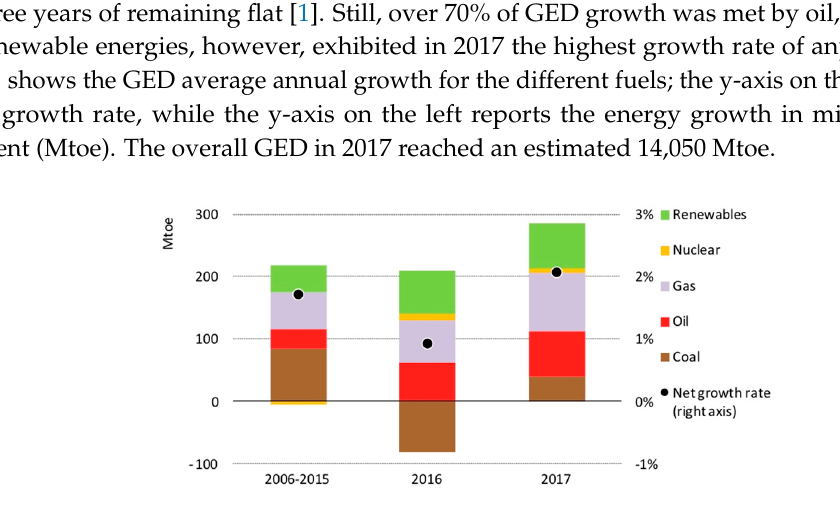
Figure 1. Average annual growth of the global energy demand (GED) by fuel. Reproduced from the IEA report [1].